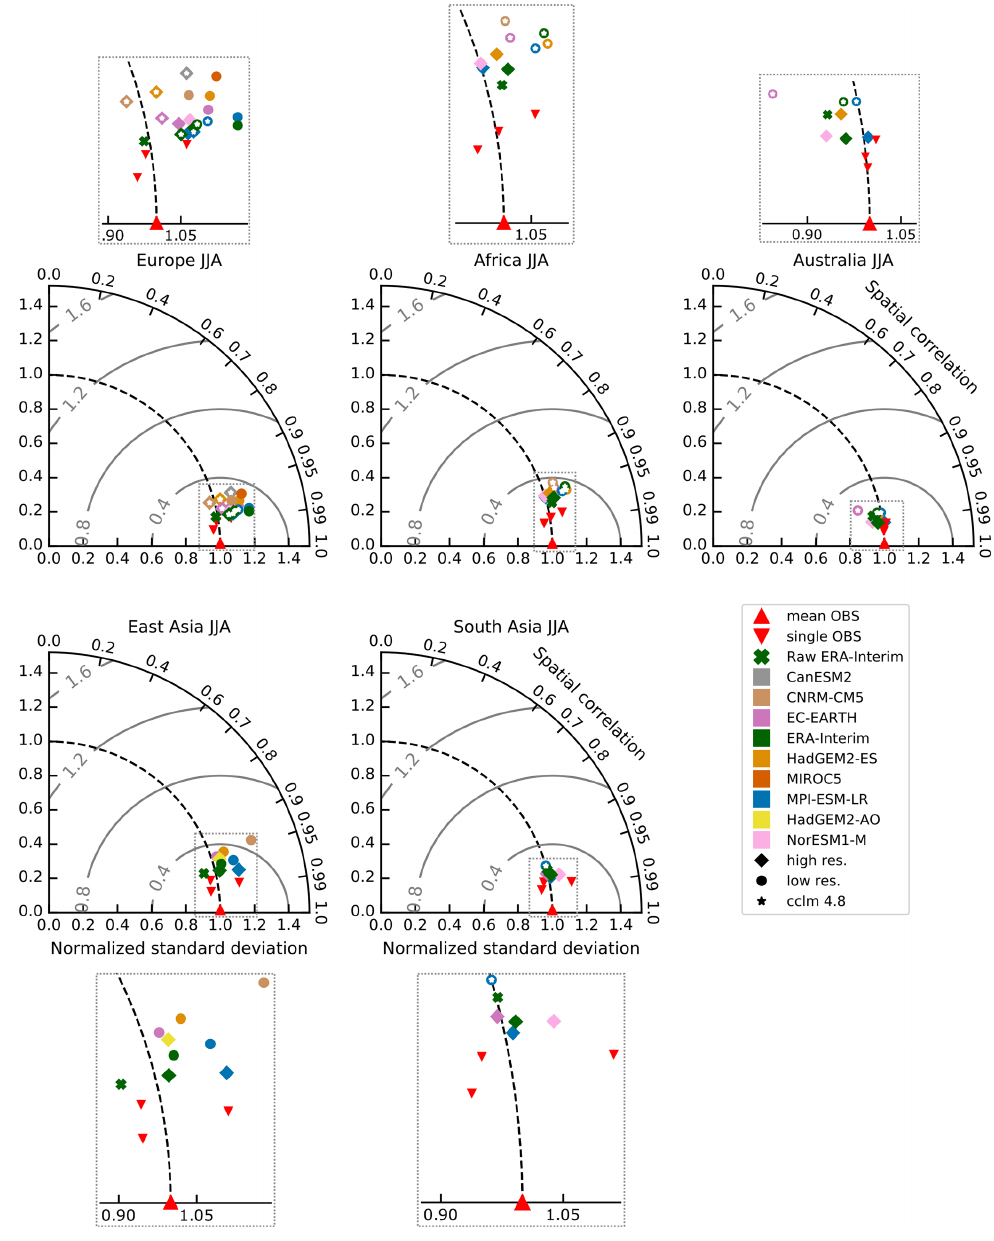
Figure 6. Same as Fig. 5 but for